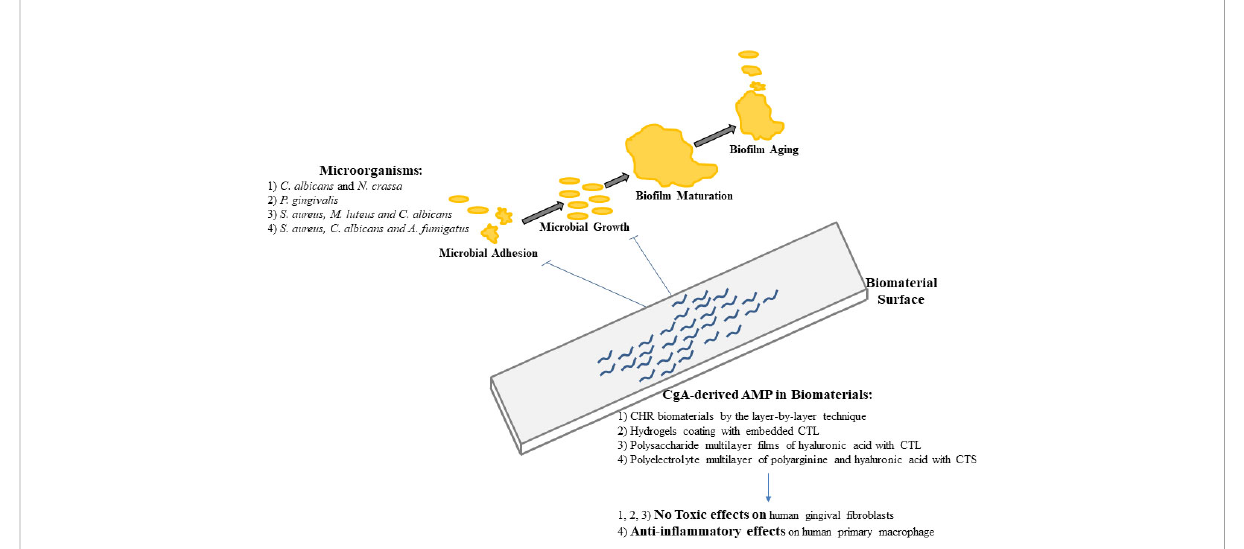
FIGURE 2 Pathogens bio fi lms development and roles of CgA-derived AMPs for the prevention of biomaterial